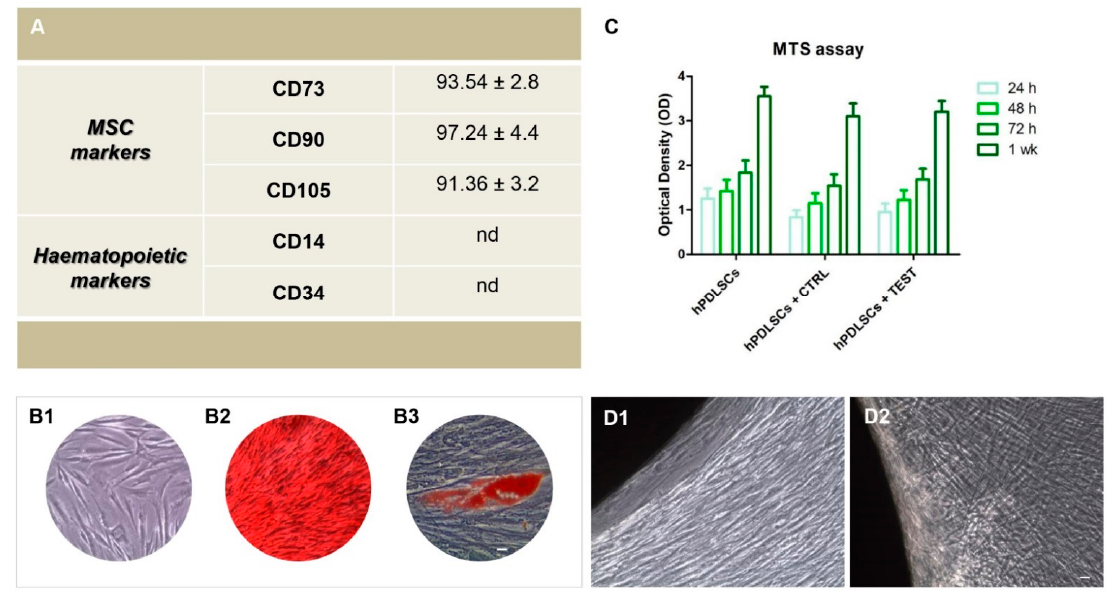
Figure 1. ( A ) Cytofluorimetric analysis of hPDLSCs primary culture at second passage. The values are expressed as mean fluorescence ratio (MFI) obtained by dividing the MFI of positive events by the MFI of negative events. ( B1 ) Plastic adherent primary cultures of hPDLSCs observed at light microscopy showed a spindle-shaped appearance with long cytoplasmatic processes. ( B2 ) The adipogenic potential of hPDLSCs grown was analyzed through the evaluation of intracellular lipid droplets by light microscopy using Oil Red O staining after adipogenic induction. ( B3 ) The osteogenic differentiation was evaluated by staining with Alizarin red S (ARS) that demonstrated the calcium deposition. ( C ) Cell viability assay at 24, 48, 72 and 1 week of culture. ( D1 ) hPDLSCs cultured with CTRL surface. ( D2 ) hPDLSCs cultured with TEST surface. Scale bar: 20 μ m.